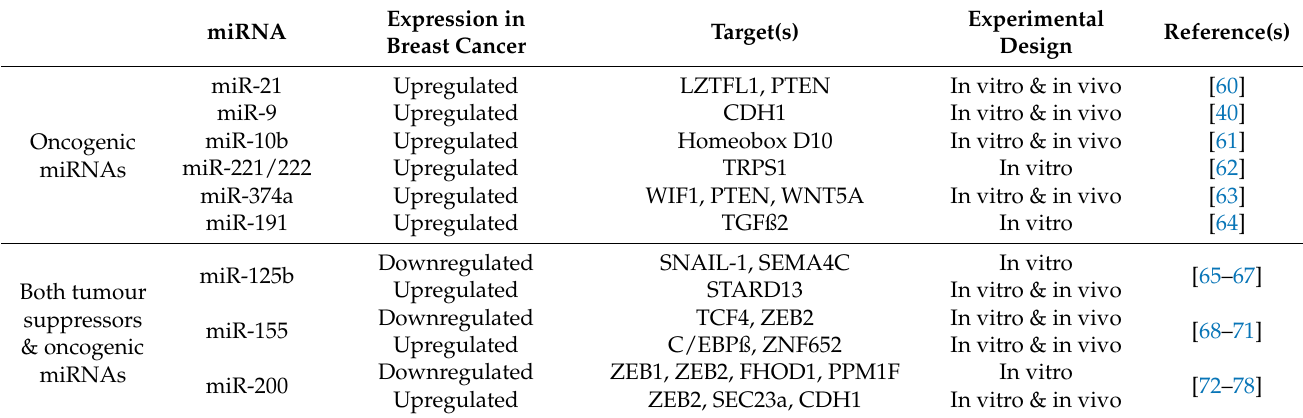
Table 2. miRNAs involved in promoting EMT, invasion and migration. Expression miRNA